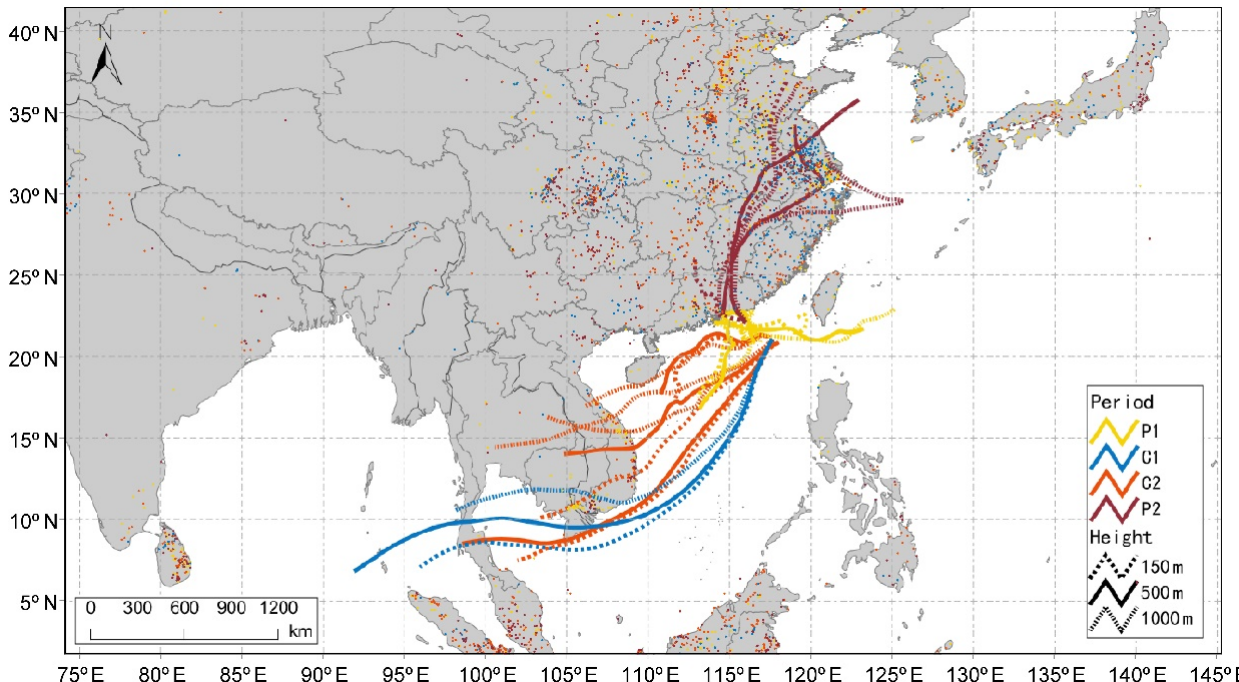
Figure 7. The 72h backward trajectories arriving at the location of the vessel with three heights (150, 500, and 1000m) during P1, C1, C2, and P2s. The dots represent the fire spots detected by MODIS.